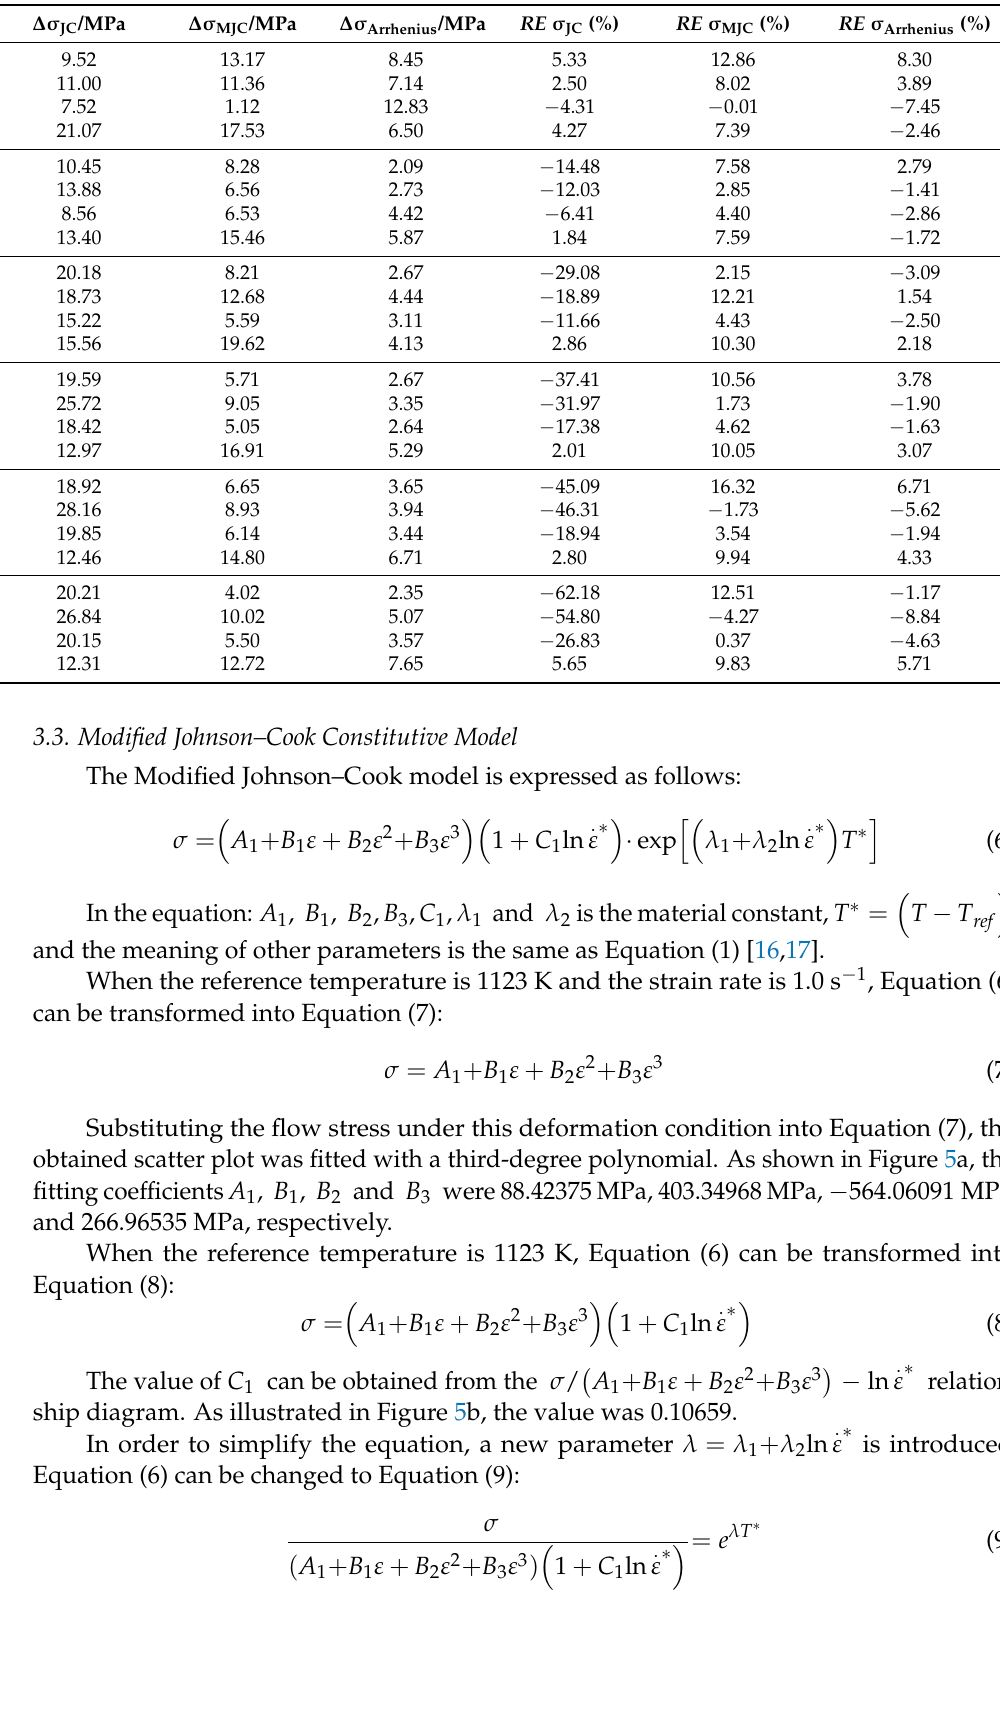
Table 3. Absolute error mean value and relative error mean value of three kinds of constitutive models under different deformation